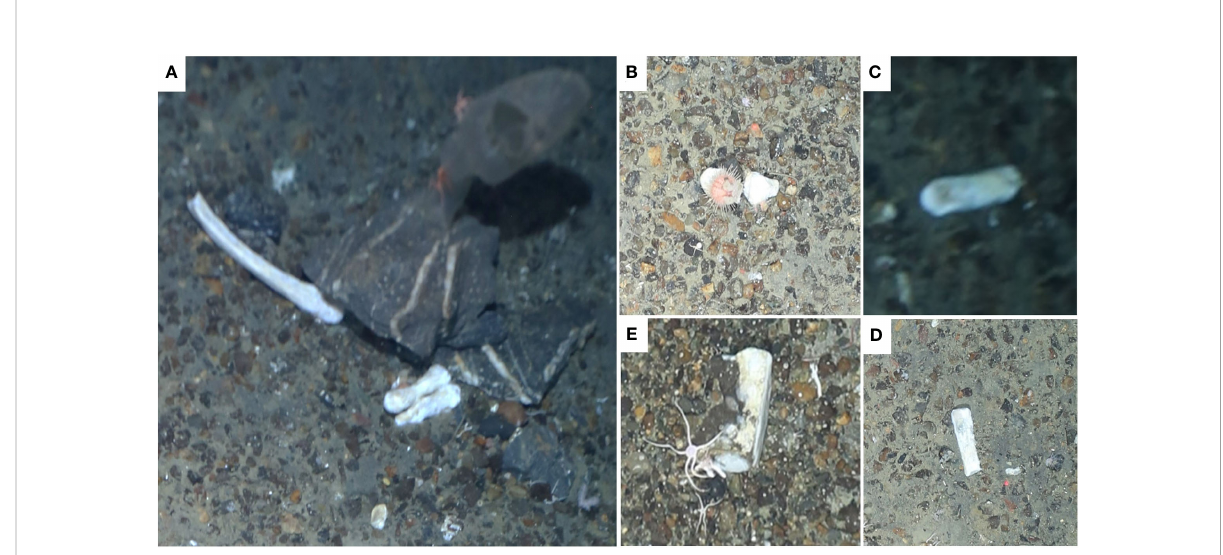
FIGURE 4 Loose bone assemblages found on the slopes of the Powell Basin during the cruise PS118. Bones (A-D) were found on three consecutive images at a water depth of around 1330 m ( “ Bones_1 ” ). Bone (E) was found at a water depth of 1328 m ( “ Bones_2 ” ). Images were cropped and light correction was applied if